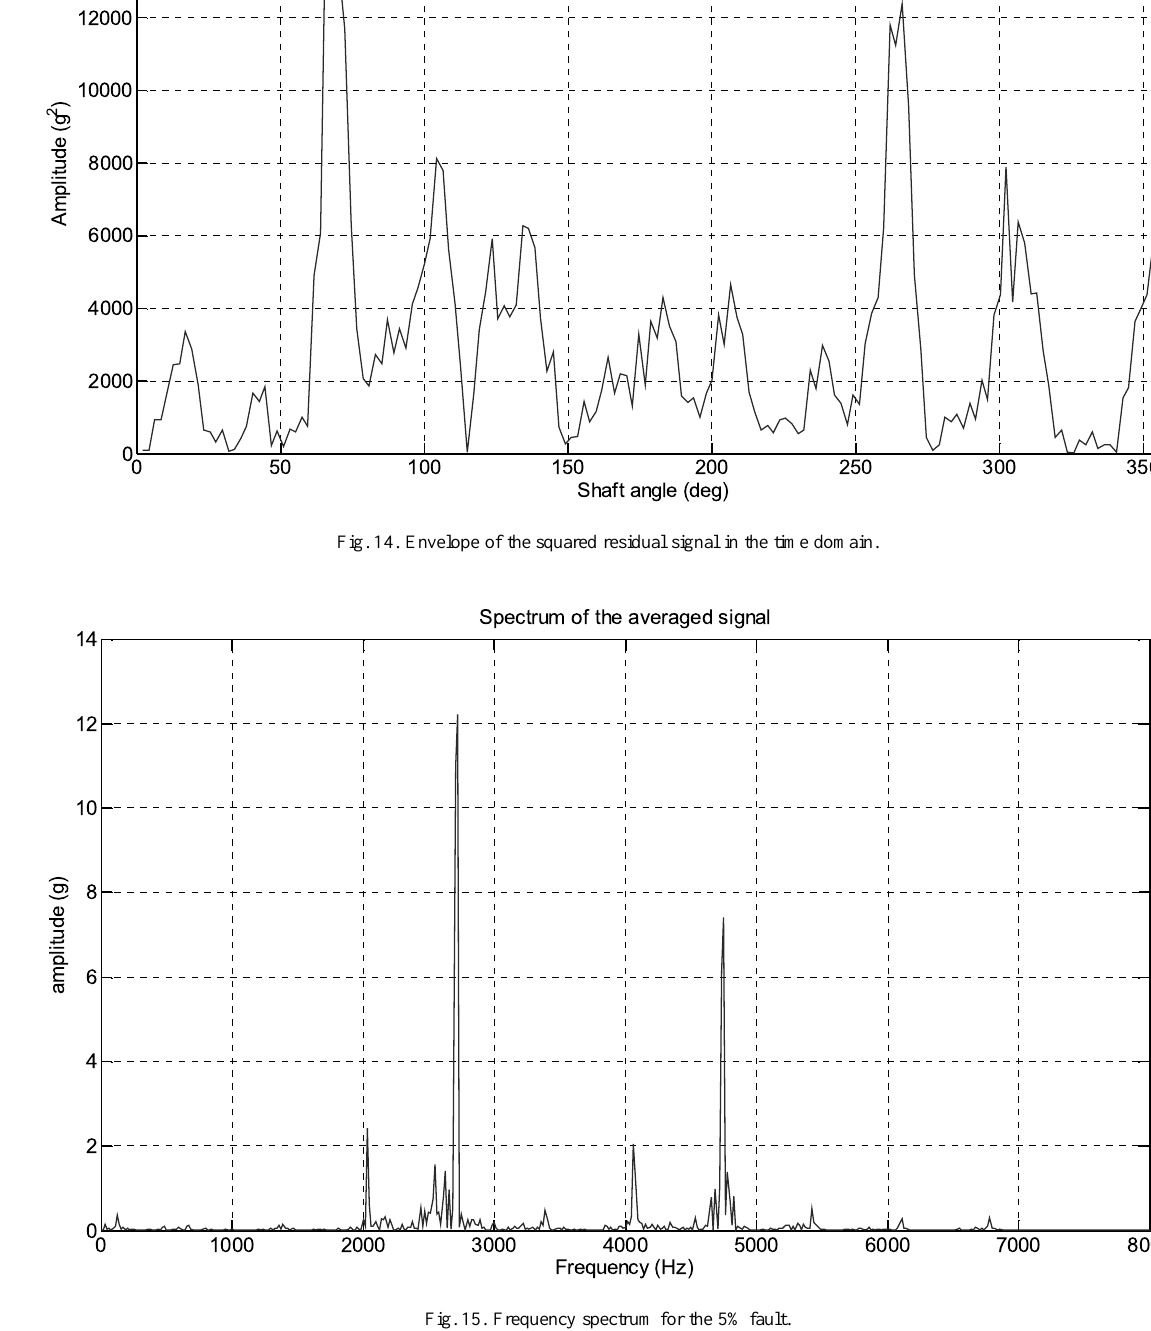
Fig. 15. Frequency spectrum for the 5%